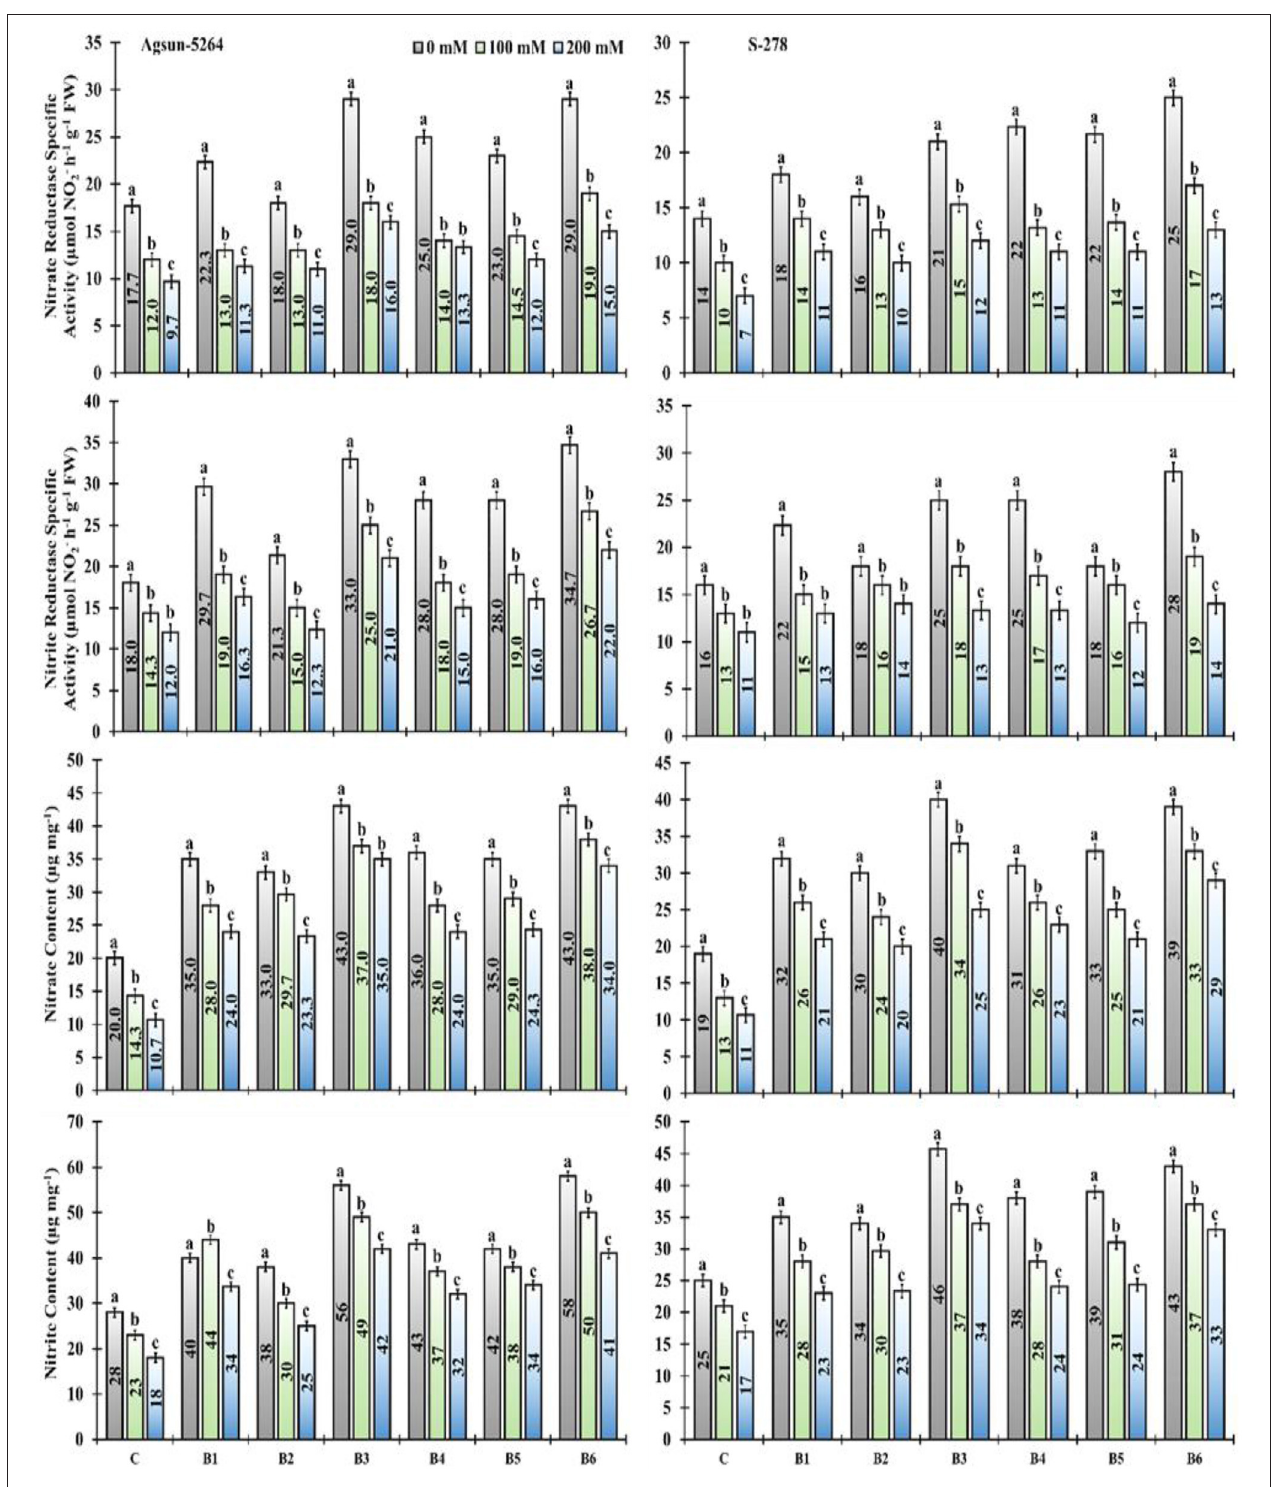
FIGURE 6 | Effect of halophilic microbial strains on changes in Nitrate reductase specific activity (NR), Nitrite reductase specific activity (NiR), Nitrate content and Nitrite content of sunflower cultivars under salinity stress. Vertical line on the bar represents mean standard error (S.E). Similar alphabet shows non-significant difference at p ≤ 0.05 ( Bonferroni post-hoc test ) between